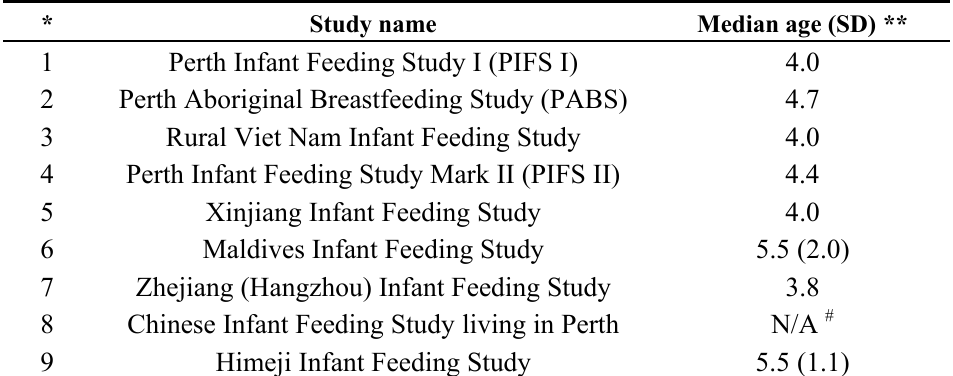
Table 3. The median age of the first introducing solid foods (in months) by the studies.